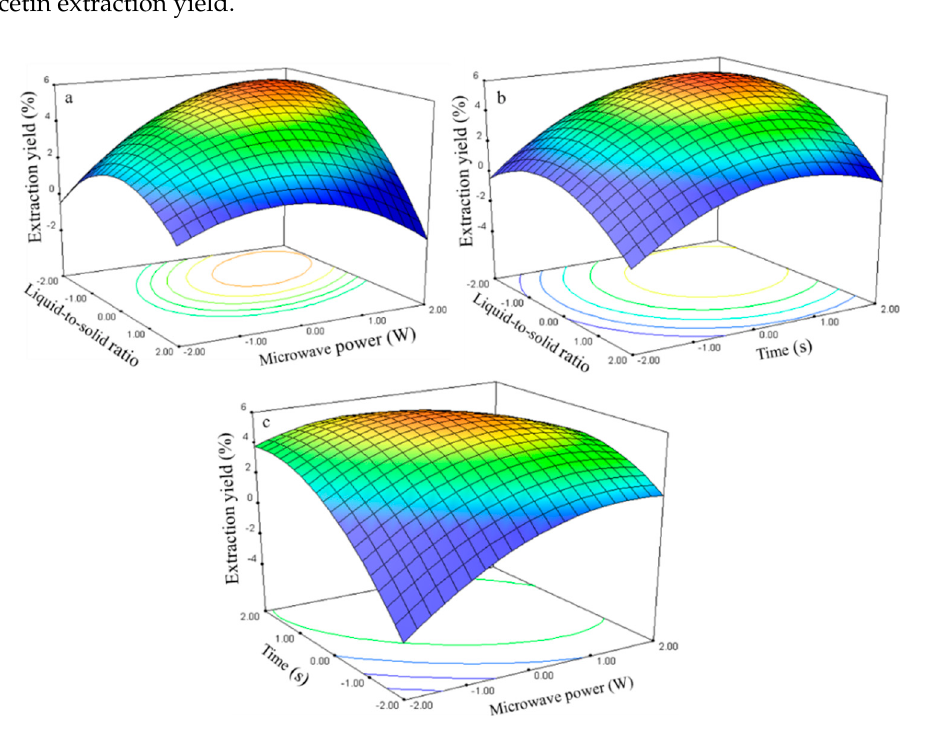
Figure 7. Response surface plots for the effects of: ( a ) liquid-to-solid ratio/power ( b ) liquid-to-solid/time ( c ) power/time on the extraction yield of rutin.